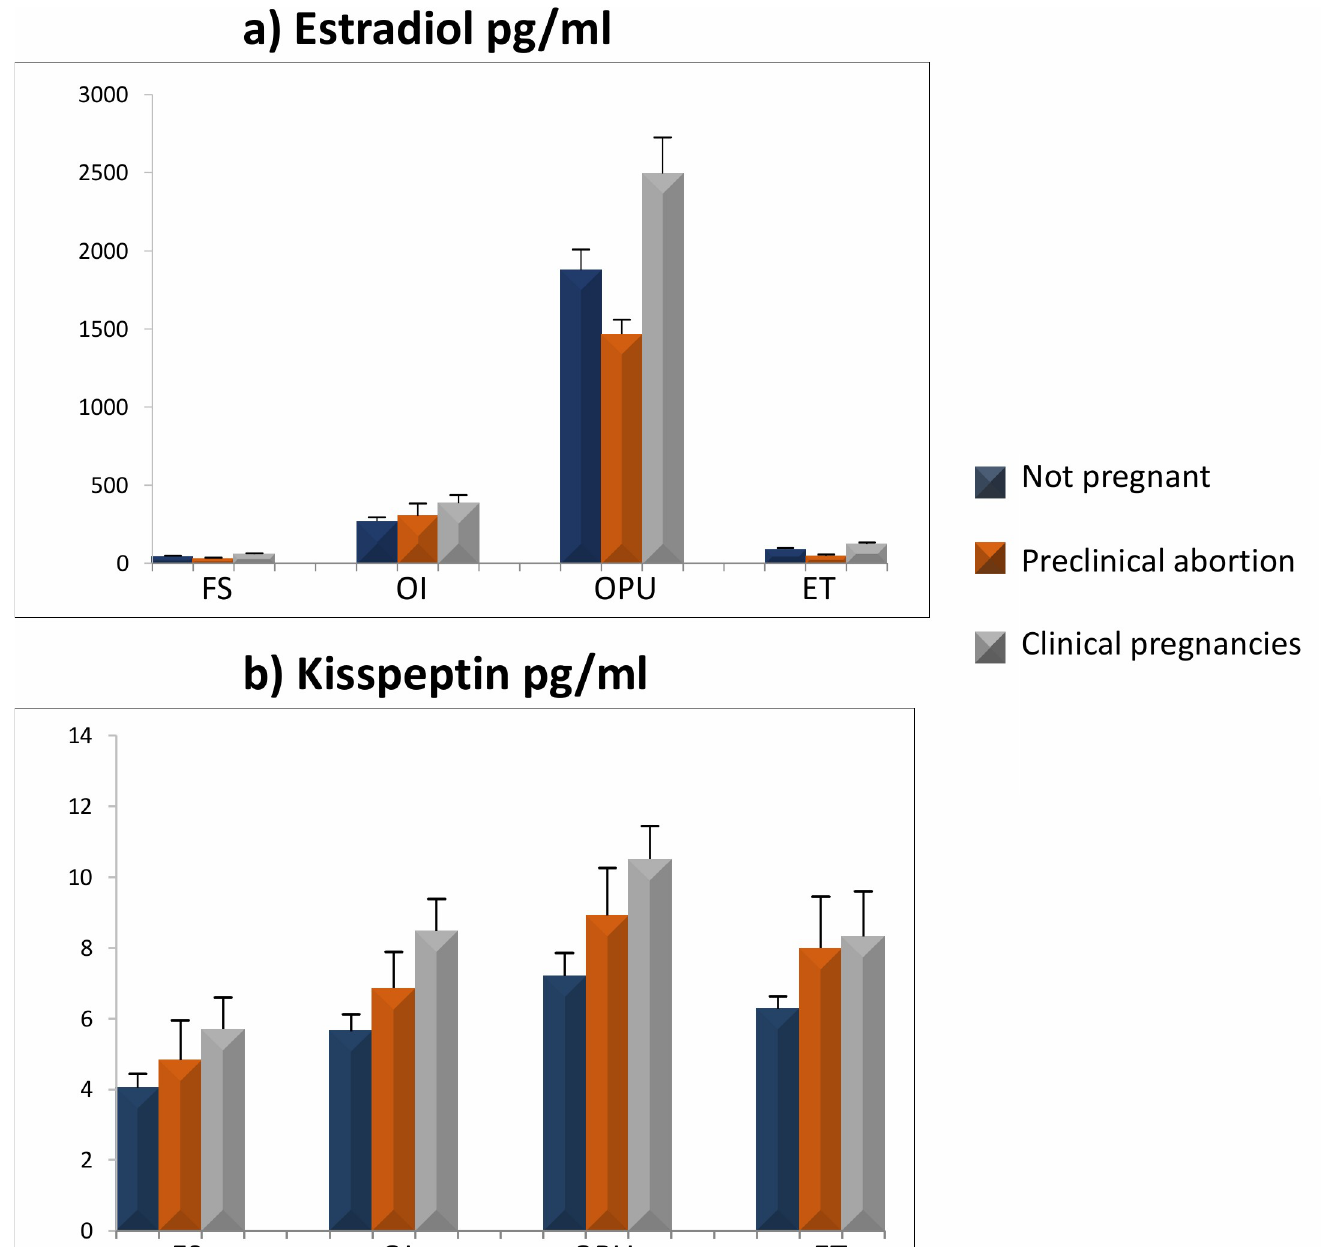
Fig 3. Comparison of estradiol (a) and kisspeptin (b) at various stages of stimulation in all three outcome groups. � Significant with stage 1 at 0.05 �� Significant with stage 1 at 0.01. FS: Follicular stimulation, OI: Ovulation Induction, OPU: Oocyte pickup, ET: Embryo transfer.